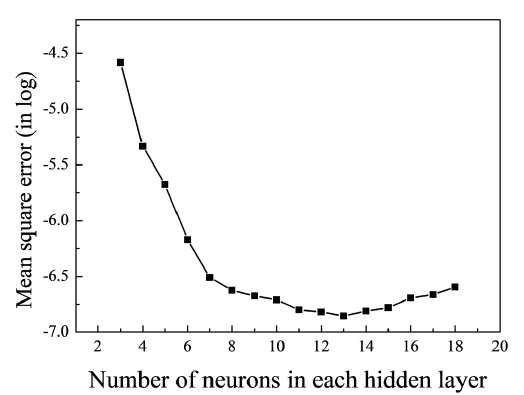
Figure 3. Performance of the network at different hidden neurons value when the neuron number in each hidden layer is 13, showing that the ANN model with 13 neurons in each hidden layer shows excellent performance. As the ANN model with 13 neurons in each hidden layer had been well trained, the performance was measured in terms of the correlation coefficient ( R ) and the average absolute relative error ( AARE ) 18-20 , as expressed by Equation 4 and Equation 5, respectively. The correlation coefficient is a widely used in measuring the strength of linear relationships between experimental and predicted values, while the average absolute relative error indicates the accuracy of the prediction. Low level of AARE -values and high level of R -values indicate that the predicted values of flow stress agree very well with the experimental value.